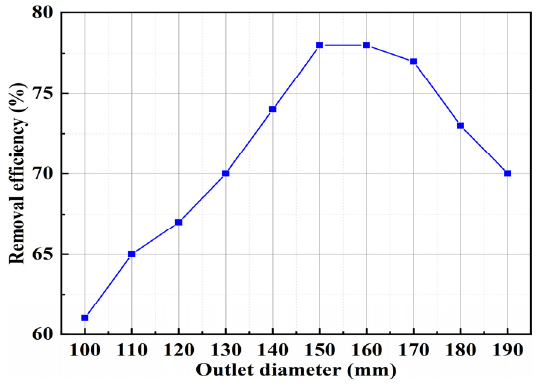
Figure 12. Effect of outlet diameter on the efficiency of dust extraction .